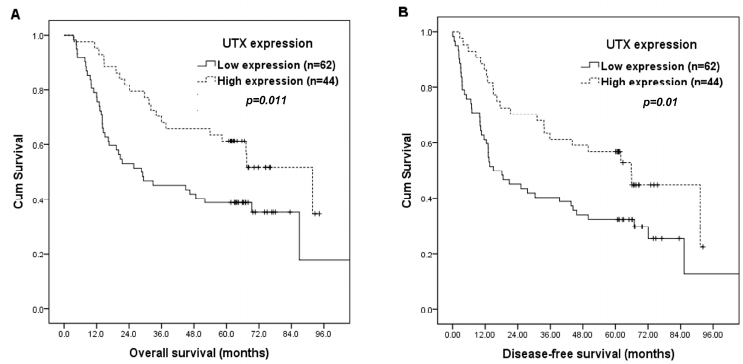
Figure 2. Kaplan-Meier curves according to UTX status. ( A ) OS rate according to UTX status. ( B ) DFS rate according to UTX status. Table 3. Results of univariate log-rank analysis of prognostic factors for overall survival (OS) and